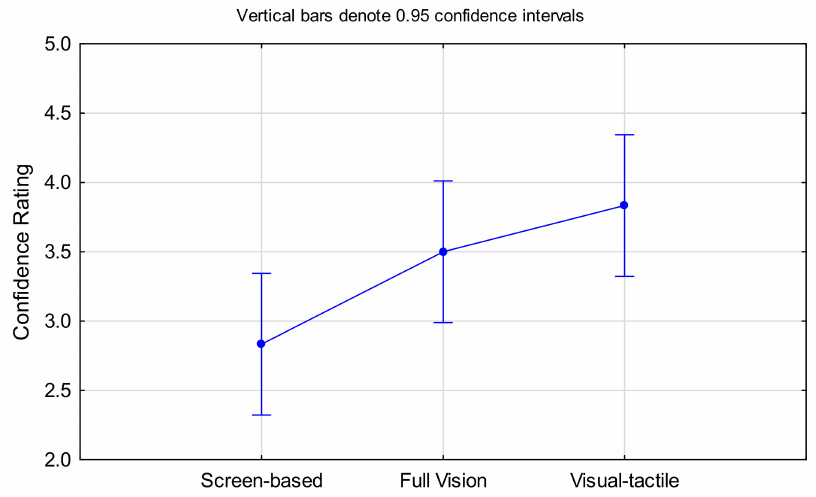
Figure 14. Confidence rating for each inspection